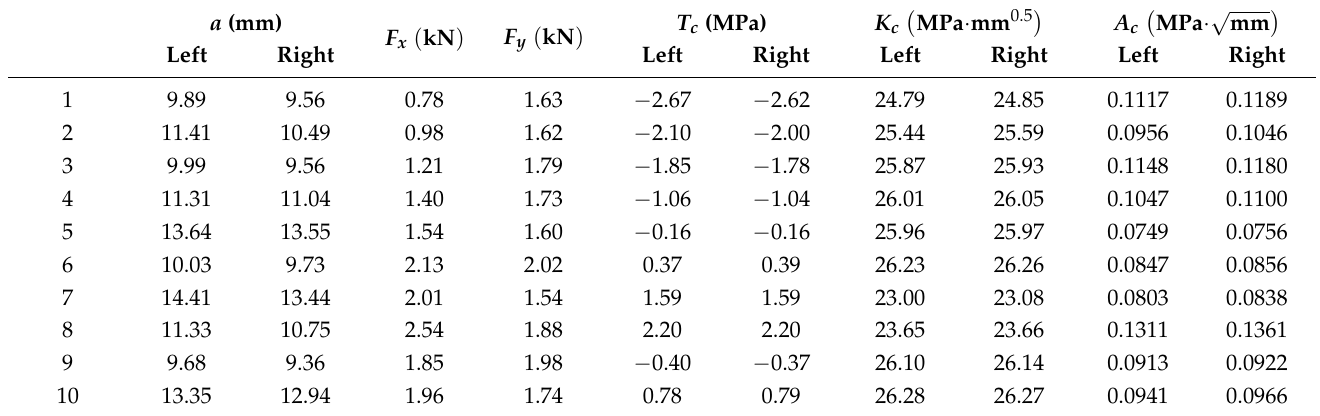
Table 1. a , F x , F y , T c , K c values in cross-shaped specimen.